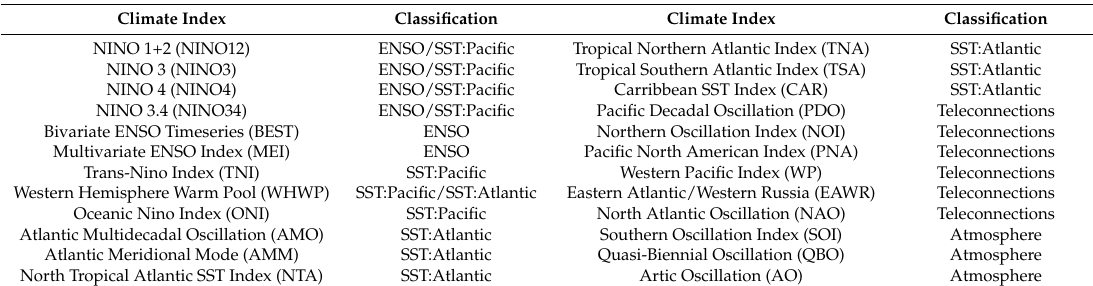
Table 2. List of the climate indices used in this study.